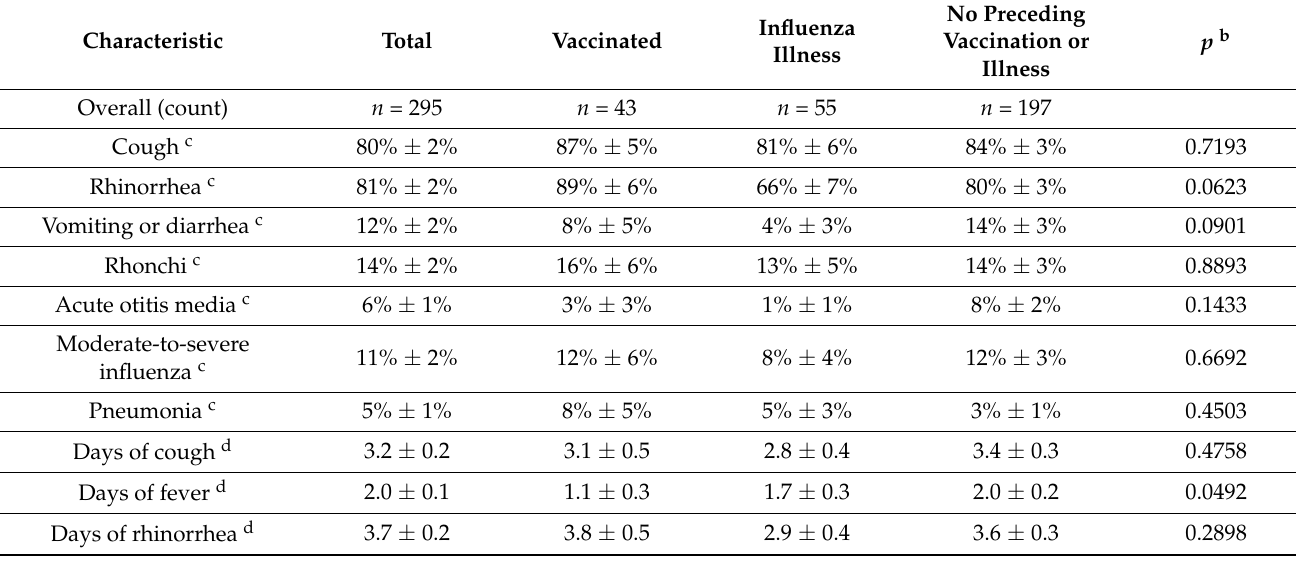
Table 3. Clinical and parent-reported outcomes (mean ± standard error) by preceding vaccination or illness for 295 a influenza episodes in a cohort of children <2 years in Managua,